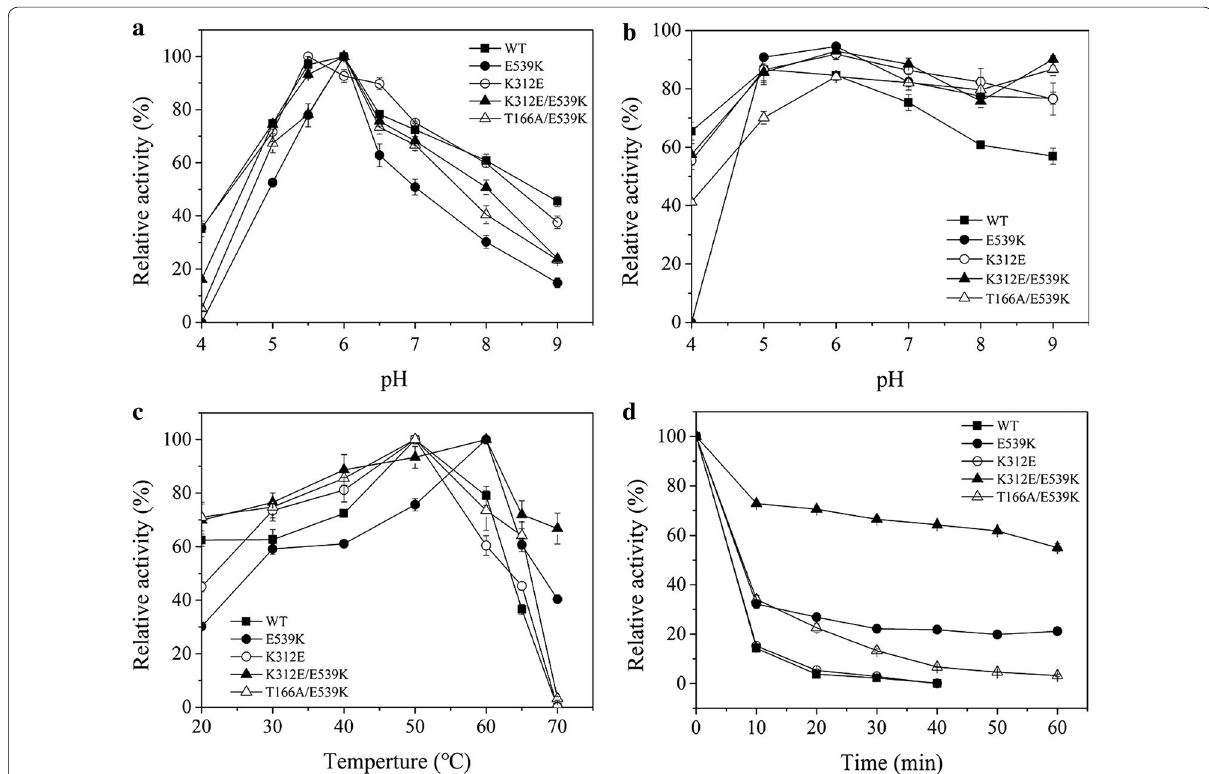
Fig. 2 Biochemical characterization of the purified recombinant Ts POx and its mutants. a pH profile; b pH stability; c temperature profile; d thermo-